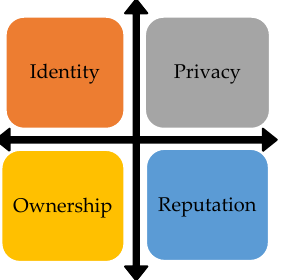
Figure 4. Ethical aspects of Big Data, ML, and AI; a few of these may relate to other emerging technologies as well.